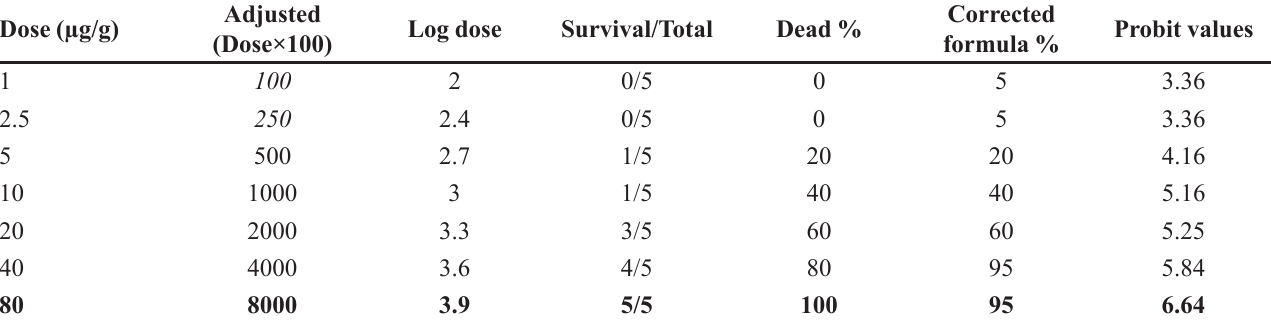
of Rauvolfia serpentina against Naja naja venom in mice by Miller and Tainter method (n=5) TABLE V - Calculation of ED 50 Dose